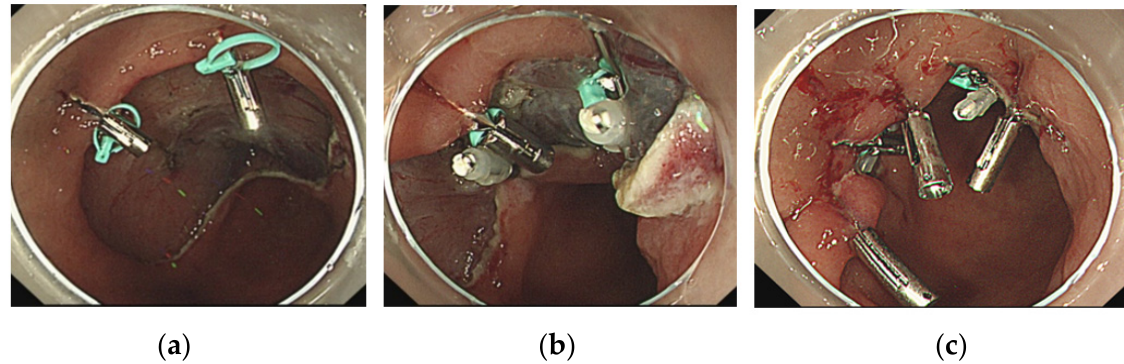
adjacent. ( f ) Clips are added for complete and adequate closure of the mucosal defect.